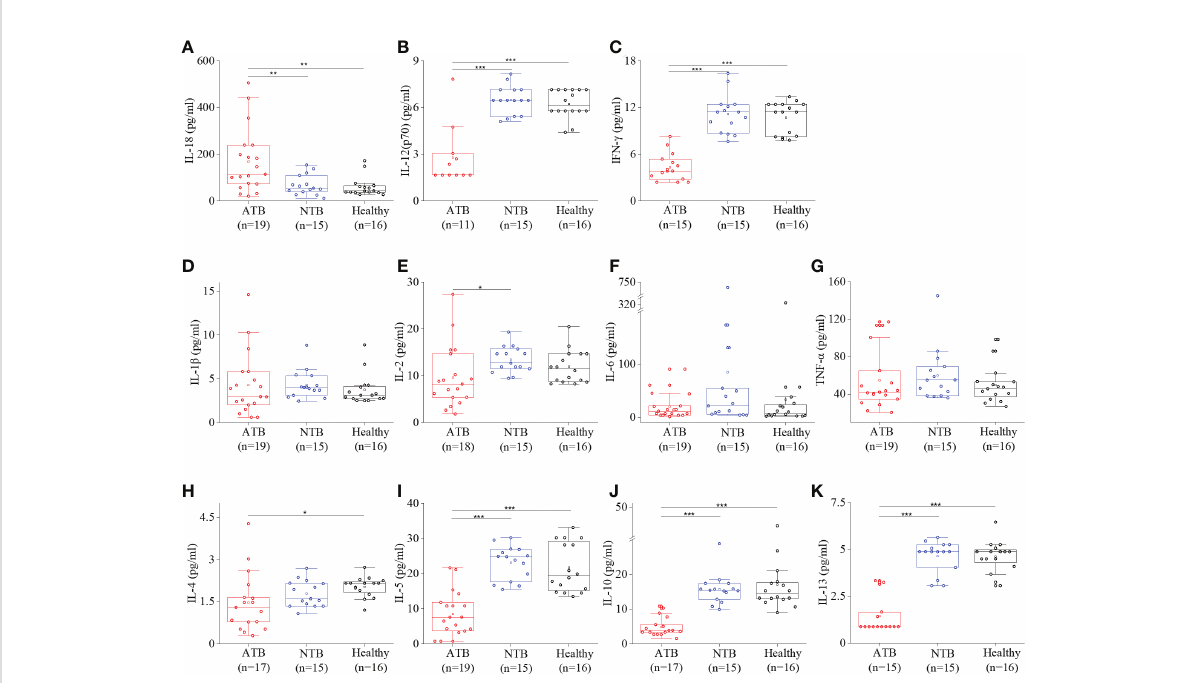
FIGURE 3 Cytokine pro fi ling showed a robust Th1 response in ATB patients. Box plots for individual serum cytokine levels using Bioplex-200 for (A) IL-18, (B) IL-12, (C) IFN- g , (D) IL-1 b , (E) IL-2, (F) IL-6, (G) TNF- a , (H) IL-4, (I) IL-5, (J) IL-10, and (K) IL-13 in ATB, NTB, and healthy groups (* p < 0.05, ** p < 0.01, *** p <